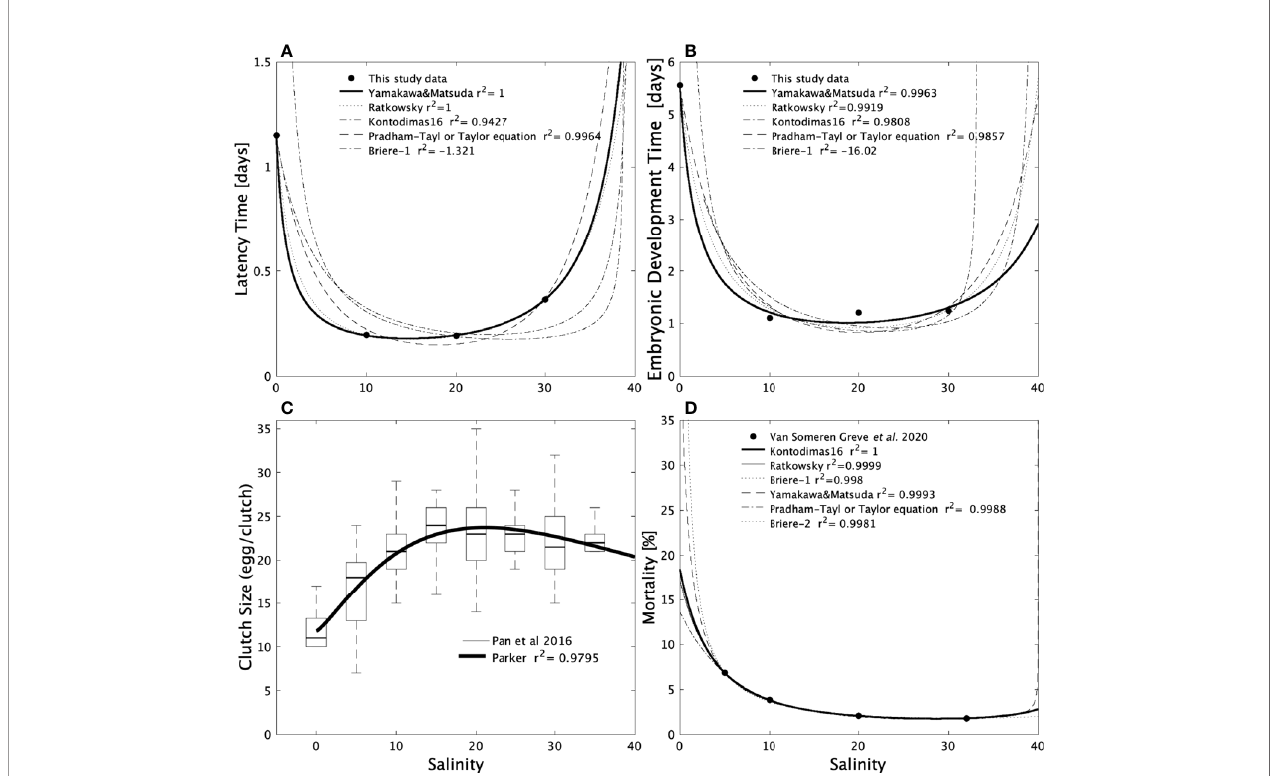
FIGURE 3 | Relationship between salinity and the Latency Time (A) Embryonic Development Time (B) , the Clutch Size (C) , and the mortality (D) . The black continuous lines represent the function implemented in the model to represent the effect of salinity. Details on the functions plotted here are provided in Supplementary Table 1